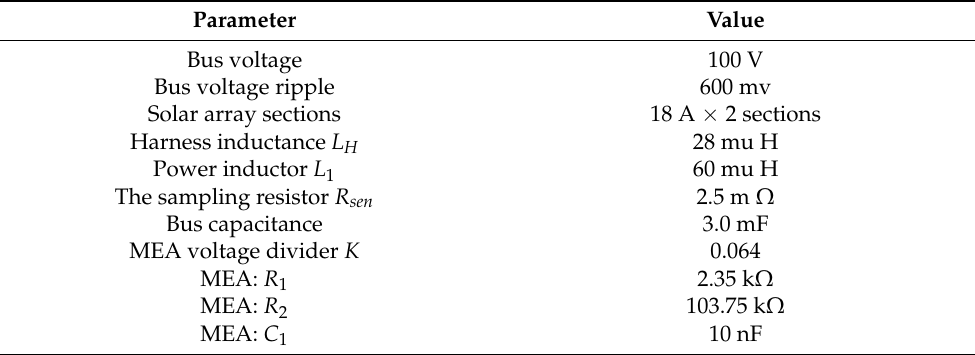
Table 1. Parameters of Platform.